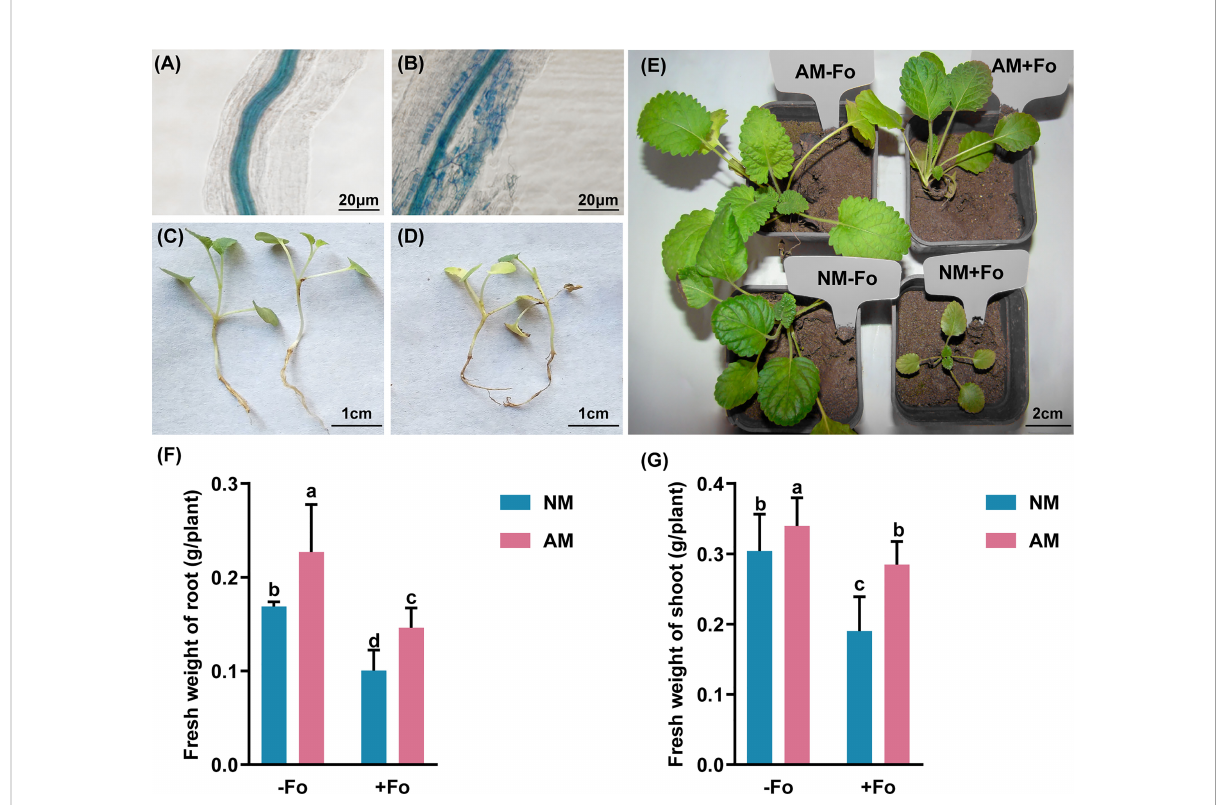
FIGURE 1 G versiforme alleviates disease of S. miltiorrhiza infected with F oxysporum . (A, B) Uncolonized roots (A) and colonized roots (B) by G versiforme . The photos were taken 30 days after mycorrhizal inoculation. (C, D) S. miltiorrhiza seedlings without pathogen inoculation (C) and diseased S. miltiorrhiza seedlings infected with the pathogen (D) . The photos were taken 7 days after inoculating with F oxysporum . (E) S. miltiorrhiza plants of four treatments 30 days after inoculating with F oxysporum . (F, G) Fresh weight of shoot (F) and root (G) of S. miltiorrhiza 30 days after pathogen inoculation. Four treatments included: (1) NM-Fo: non-mycorrhizal S. miltiorrhiza inoculated with heat-killed pathogen inoculation; (2) NM+Fo: non-mycorrhizal S. miltiorrhiza inoculated with pathogen; (3) AM-Fo: mycorrhizal S. miltiorrhiza inoculated with heat- killed pathogen; (4) AM+Fo: mycorrhizal S. miltiorrhiza inoculated with pathogen. Values are means ± SD from four sets of independent experiments with 30 pots per treatment for each set of experiments. Different lowercase letters indicate signi fi cant differences between different treatments according to two-way ANOVA followed by Tukey ’ s test for multiple comparisons ( P <